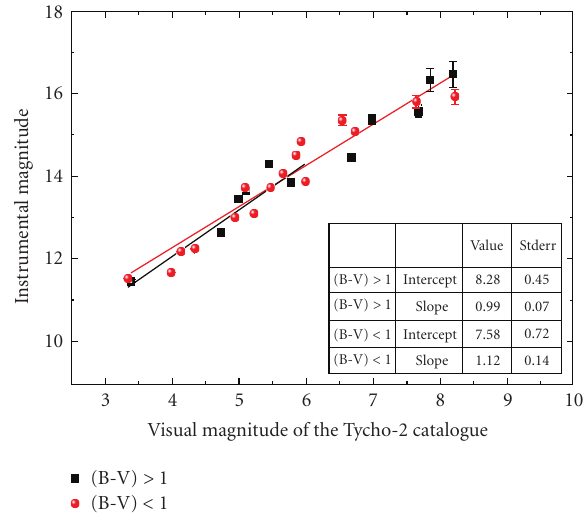
Figure 6: Instrumental magnitude versus standard Visual magni- tude. The stars with color index (B-V) > 1 and (B-V) < 1 are plotted with square and circle symbols, respectively. The reference stars under consideration are labeled in Figure 1 using the Tycho-2 identification number (id number). The values of the linear best-fits are reported in the right upper